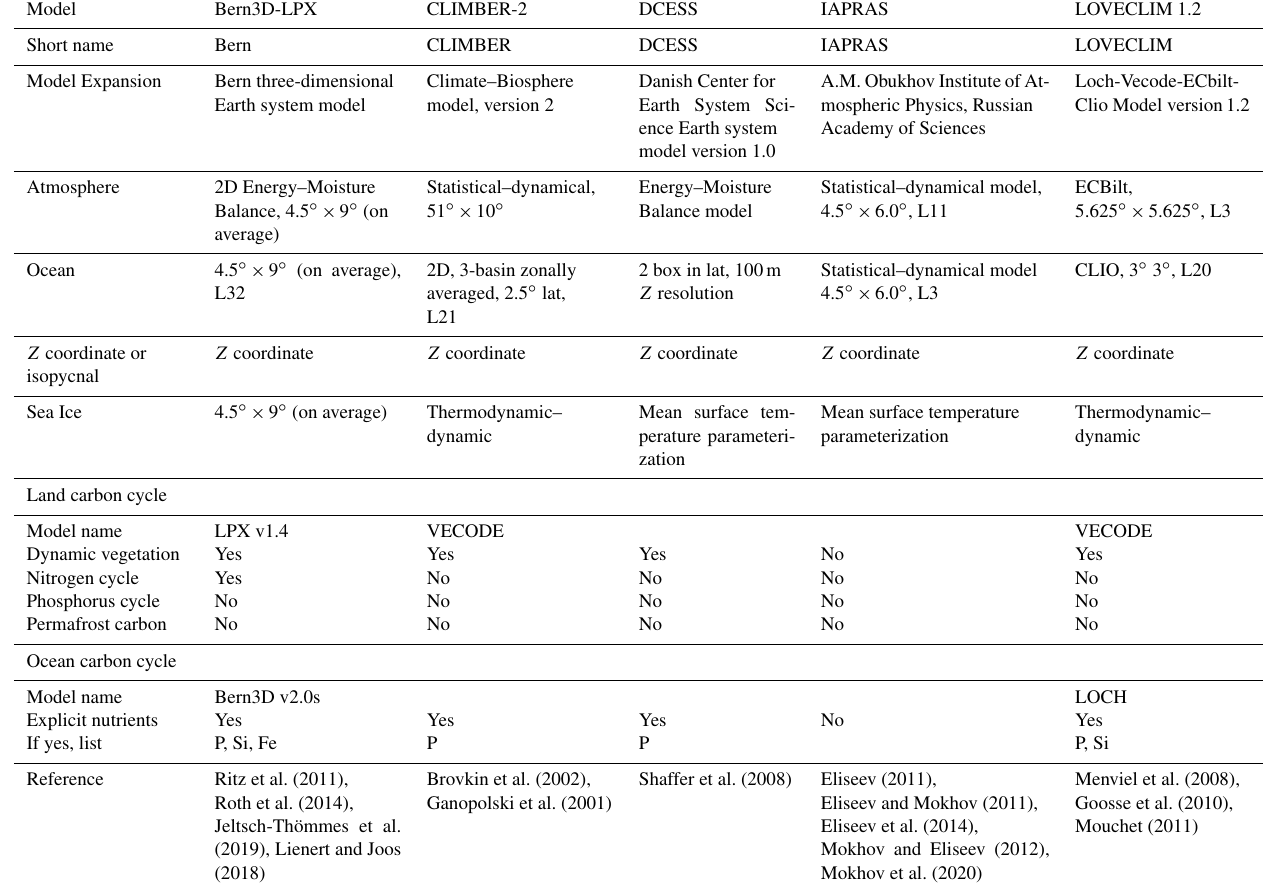
Table A2. Model descriptions of the atmospheric, oceanic, and carbon cycle components for Earth system models of intermediate complexity (EMICs) that participated in this